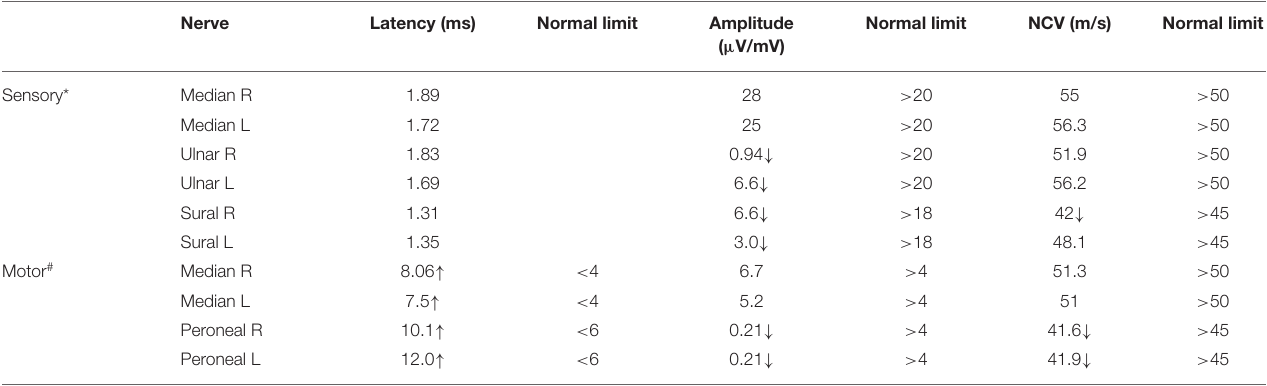
TABLE 1 | Nerve conduction study results of the patient. Nerve Latency (ms) Normal limit Amplitude